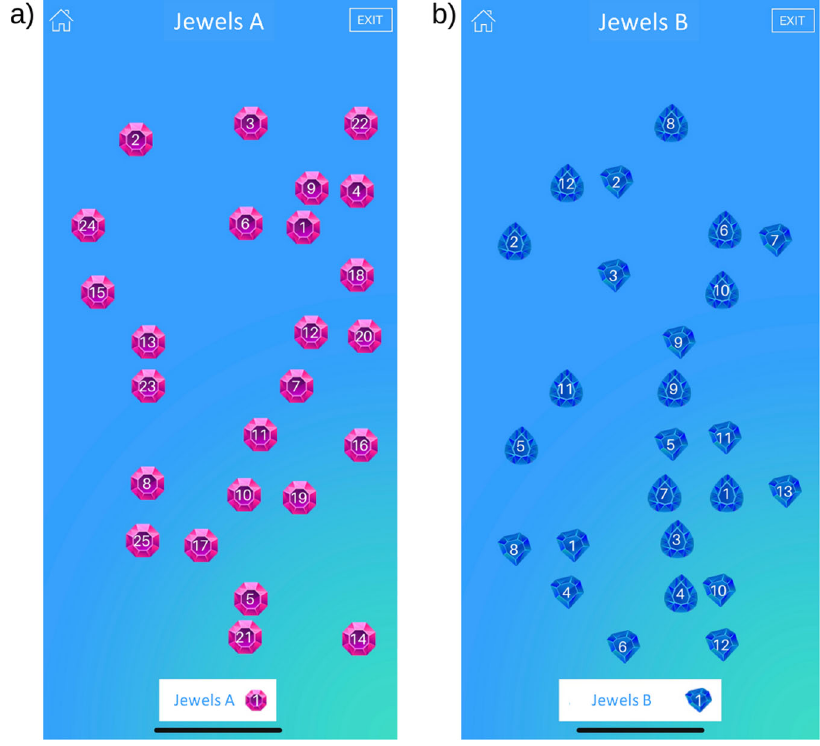
Fig. 1 JTT smartphone-based cognitive assessments on the mindLAMP app. a On the JTT A, participants tap on the numbers in chronological order, b on the JTT B; participants alternate between numbers and letters in chronological